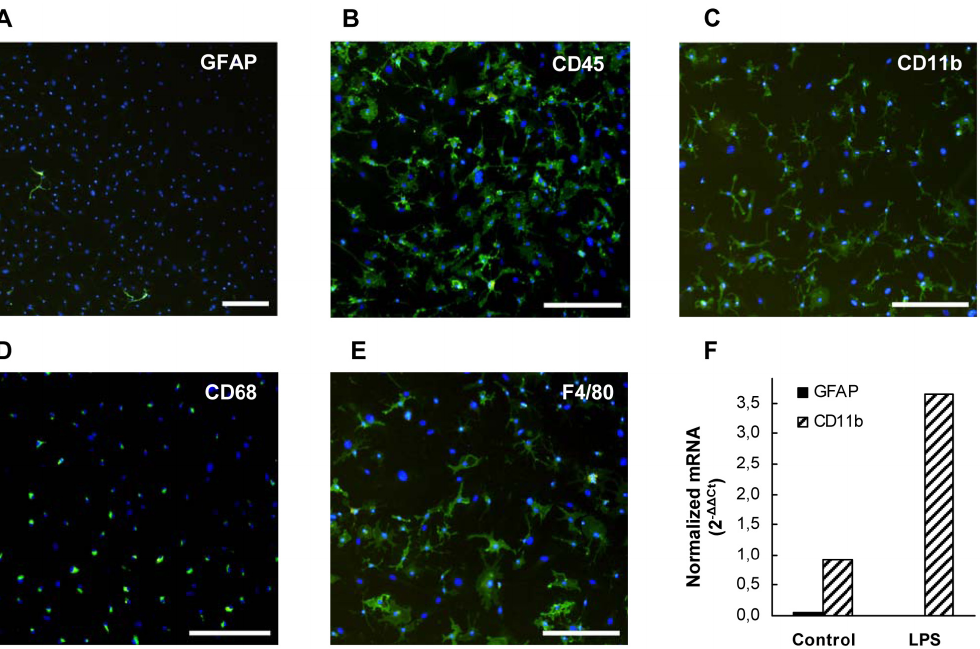
Figure 2. Evaluation of the purity of isolated microglial cell fractions. Immunofluorescence characterization of purified microglial cell cultures for the specific macroglial lineage marker GFAP ( A ), the pan haematopoietic lineage marker CD45 ( B ), and the mature macrophages markers CD11b ( C ), CD68 ( D ), and F4/80 ( E ). Nuclei are counterstained in blue with Hoechst 33342. Scale bar: 100 m m. mRNA expression (qRT-PCR) from isolated microglial preparations after no stimulation (control) or after stimulation with 1 m g/ml LPS for 20 hours ( F ). Specific primers for amplifying the GFAP and CD11b genes were used.